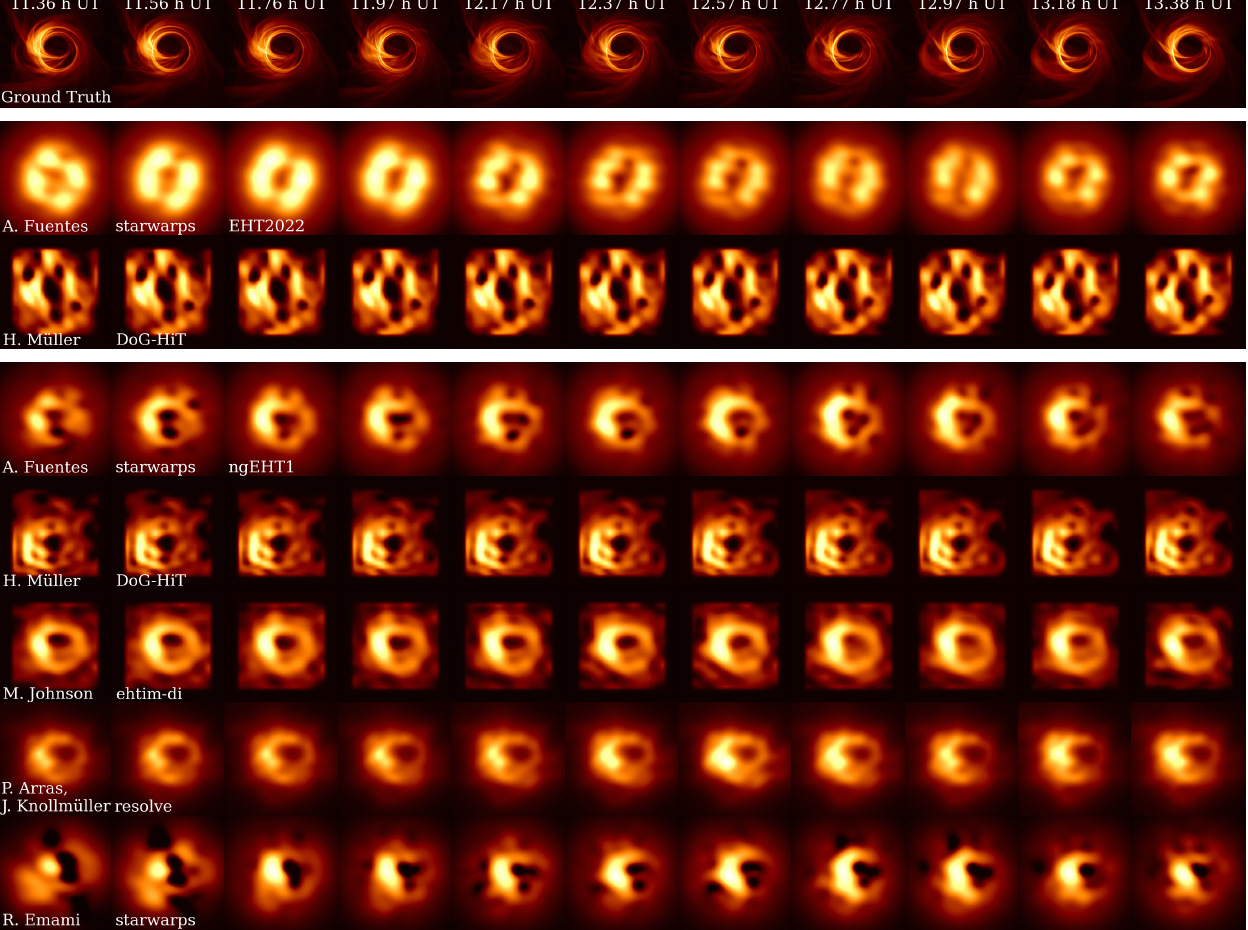
Figure 14. Challenge 2 Sgr A* GRMHD 230 GHz submissions. Images are shown on a square root scale, which is normalized to the brightest pixel value across each submitted set of movie frames on a field of view of 126 µ